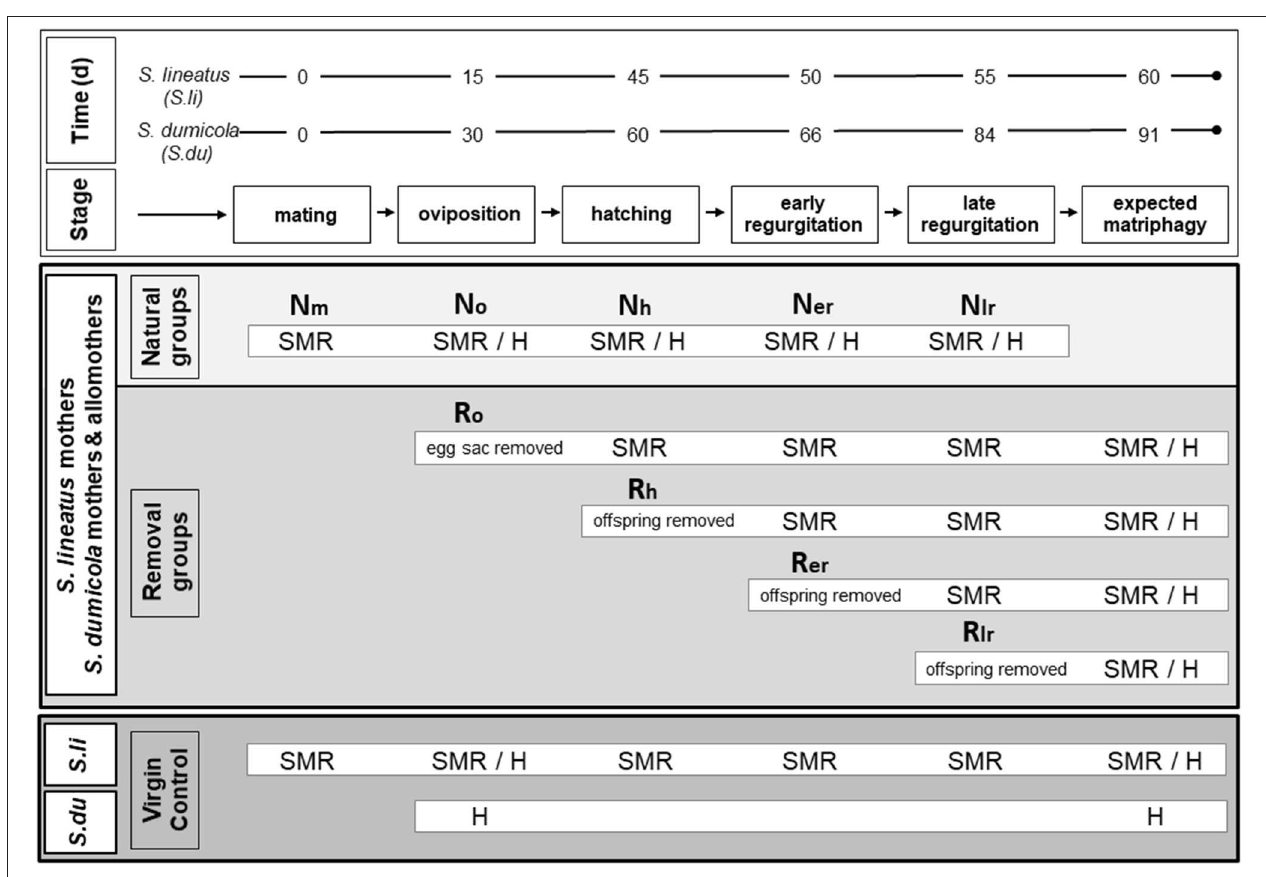
FIGURE 1 | Experimental design for examining physiological effects of brood care in females of the subsocial S. lineatus and cooperative S. dumicola . Upper box (white): representative time frames in days (d) for the reproductive cycle in the solitary breeding S. lineatus ( S. li ) and the cooperative breeding S. dumicola ( S. du ). Middle box (light/medium gray): treatment of the experimental females ( S. li : mothers; S. du : mothers and non-reproducing helpers/allomothers). Natural groups (light gray): SMR measurements or chemical fixation for histological analyses (H) took place after mating (Nm), oviposition (No), hatching of offspring (Nh), early in the regurgitation period (Ner; S. li = 5 days after hatch; S. du = 6 days after hatch) and late in the regurgitation period (Nlr; S. li = 10 days after hatch; S. du = 24 days after hatch). Removal groups (medium gray): egg sacs or offspring were removed at different stages (Ro/oviposition, Rh/hatching, Rer/early and Rlr/late